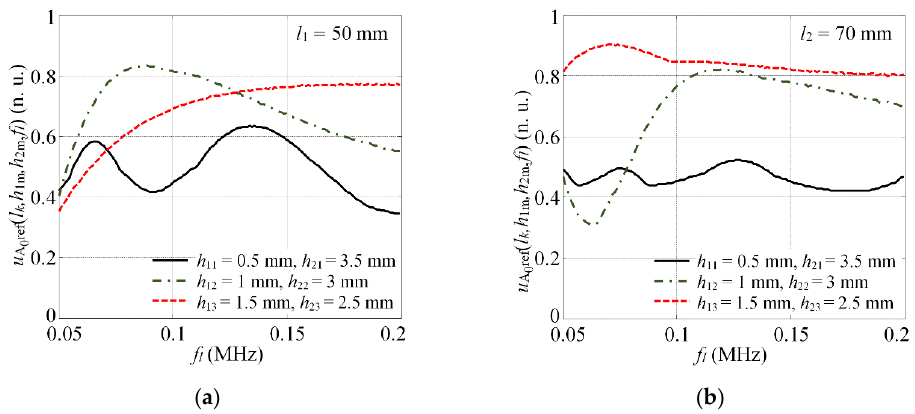
Figure 6. Magnitude variation of transmitted A 0 mode versus frequency at different defect depths in case the length of defect is equal to x 1 = 50 mm ( a ) and x 2 = 70 mm ( b ).